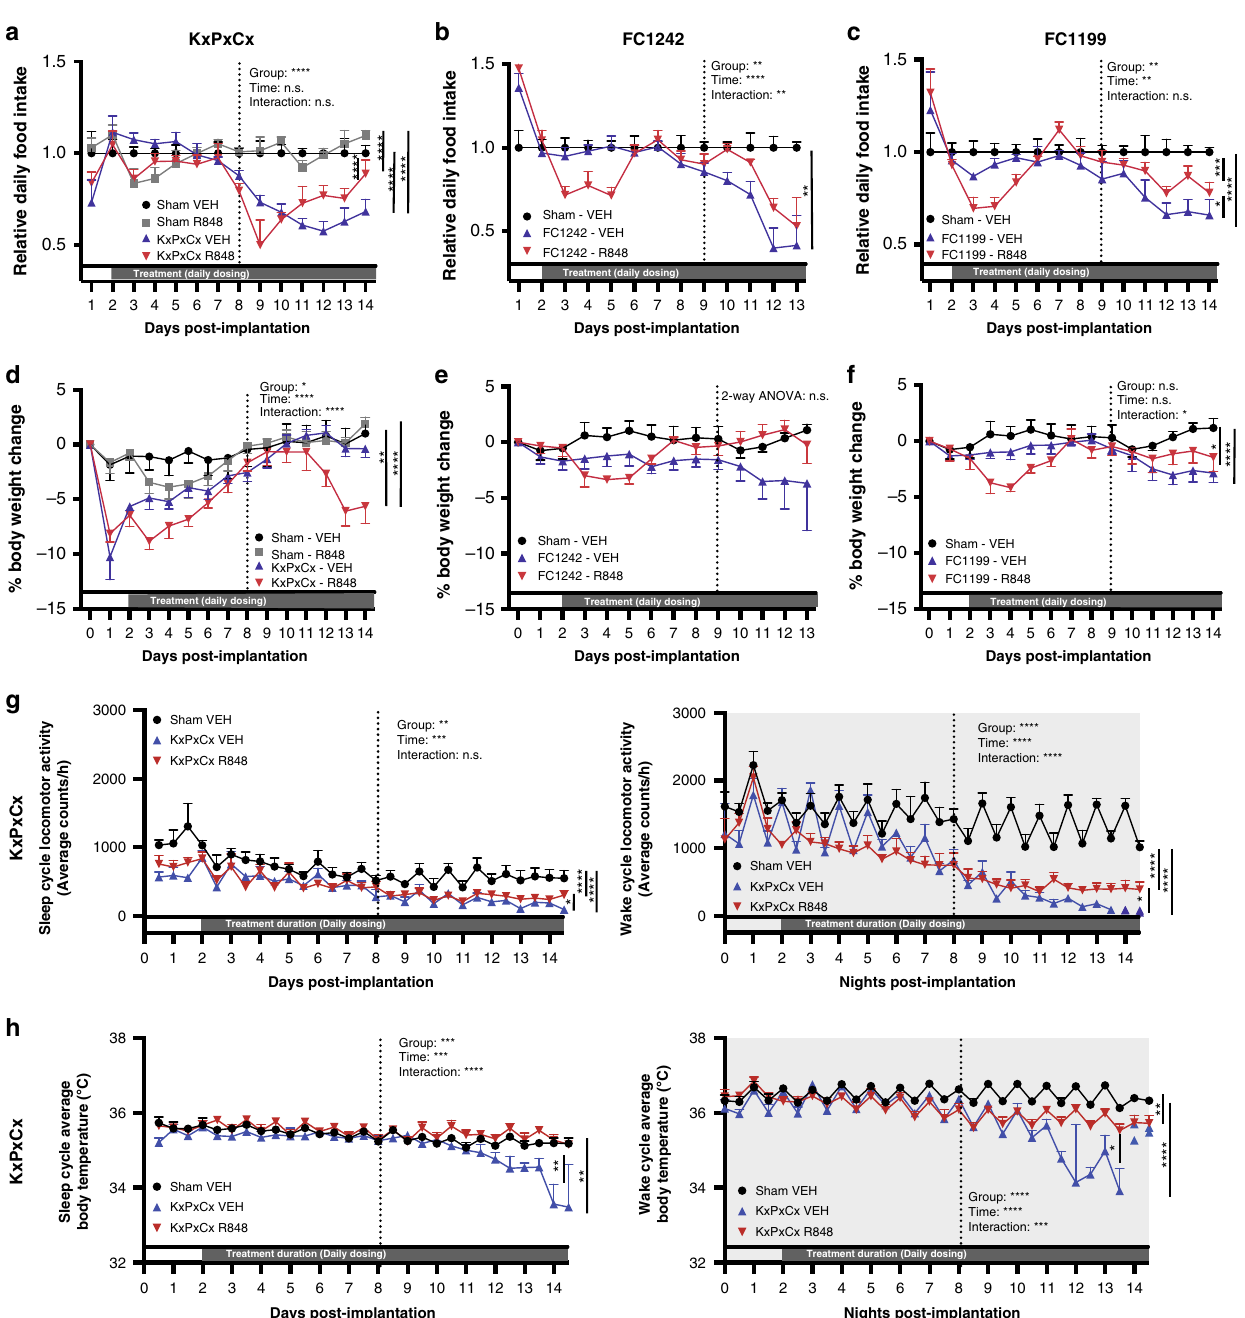
Fig. 3 R848 improves cachexia manifestations in murine PDAC models. Mice were orthotopically implanted with one of three distinct syngeneic KPC- derived cell lines: KxPxCx, FC1199, and FC1242. Vertical dotted lines denote the onset of cachexia as de fi ned by consistent hypophagia exceeding 10% below control food intake. KxPxCx studies were performed independently, whereas FC1242 and FC1199 studies were performed concurrently with a shared control group. a Food intake relative to sham-operated vehicle-treated mice (Sham-VEH) for sham-operated R848-treated mice (Sham-R848), KxPxCx- engrafted mice receiving vehicle (KxPxCx-VEH), and KxPxCx-engrafted mice receiving R848 (KxPxCx-R848). b , c Food intake relative to sham-operated vehicle-treated mice implanted for FC1242 ( b ) and FC1199 ( c ) treated with vehicle (VEH) or R848. d – f Body weight relative to baseline for KxPxCx ( d ), FC1242 ( e ), and FC1199 ( f ) throughout treatment with R848 or vehicle. g Average locomotor activity during day/sleep and night/wake cycles for KxPxCx- implanted animals treated with R848 or vehicle, binned into 6 h intervals. h Average body temperature during day/sleep and night/wake cycles for KxPxCx-implanted animals treated with R848 or vehicle, binned into 6 h intervals. Data for all panels are displayed as mean ± SEM, unless fewer than three subjects were remaining in a group, in which case individual data points are plotted. Statistics were performed as two-way ANOVA during the cachexia stage to test for main effects of tumor and treatment, and the interaction thereof, with multiple comparisons to test for main column effects. Comparisons are two-way ANOVA analyzing group by time, with multiple comparison analysis of the main column effect during cachexia stage. * P < 0.05; ** P < 0.01; *** P < 0.001; **** P <